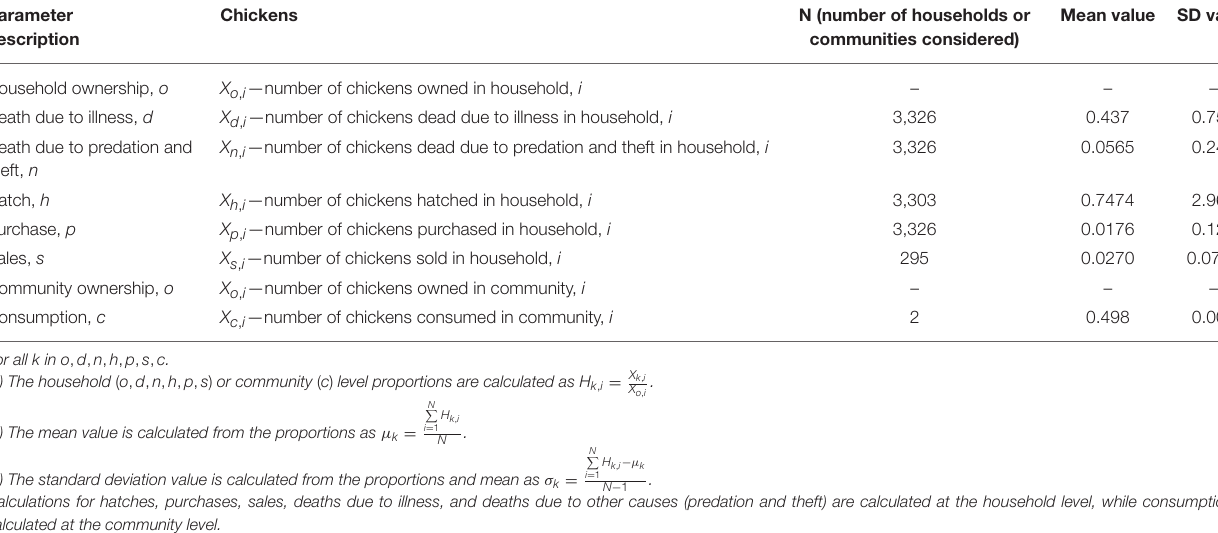
TABLE 2 | Calculations and values for hatches, purchases, sales, deaths due to illness, deaths due to other causes (predation and theft), and consumption. Parameter